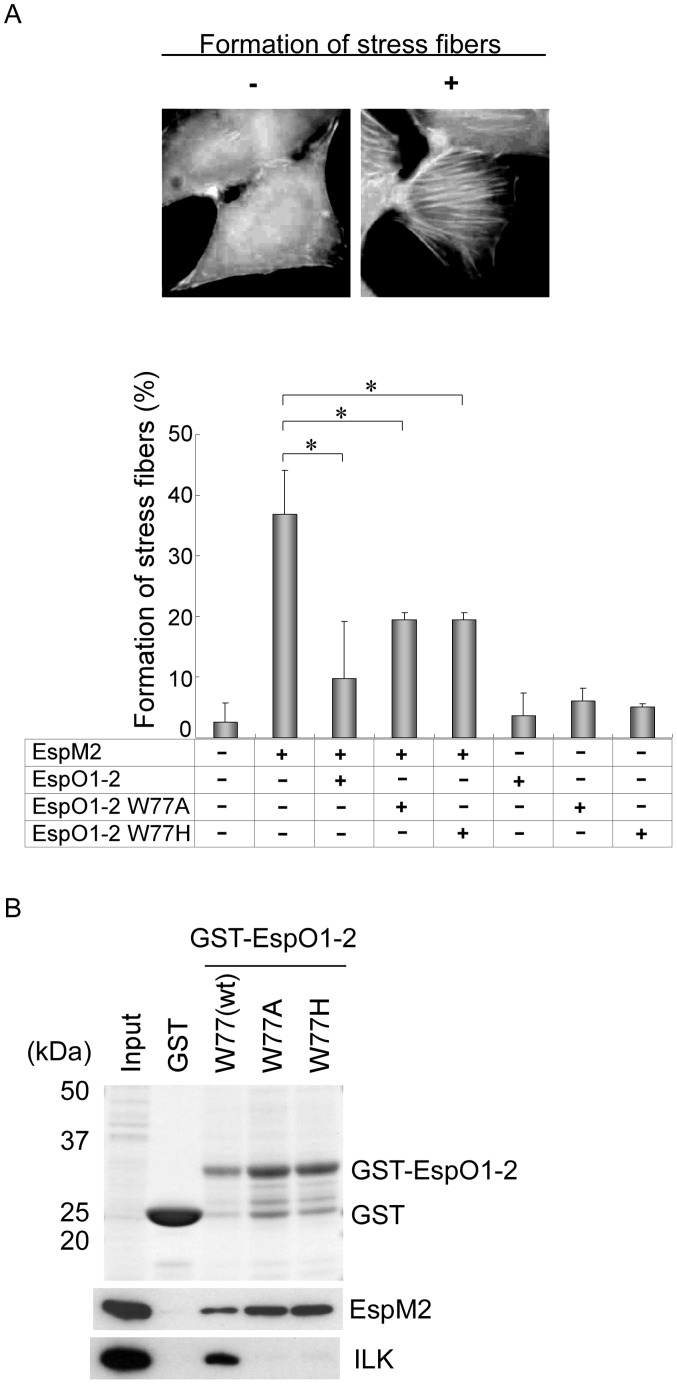
Interaction between EspO1-2 and EspM2 inhibits formation of stress fibers induced by EspM2.(A) HeLa cells transfected with pREP, pRFP-EspO1-2, pRFP-EspO1-2 W77A or pRFP-EspO1-2 W77H and pEGFP or pEGFP-EspM2 were immunostained with Alexa 350-conjugated phalloidin to visualize actin filaments and stress fibers (upper panels). Percent of transfected cells in which formation of dense stress fibers, as shown in the upper right panel, was induced (lower graph). (B) To investigate the effect of the EspO1-2 Trp77 residue on EspM2 binding, GST-EspO1-2 W77A and GST-EspO1-2 W77H, each with an amino acid substitution for EspO1-2 Trp77, were used in binding assays with cell lysate expressing Flag-tagged EspM2.